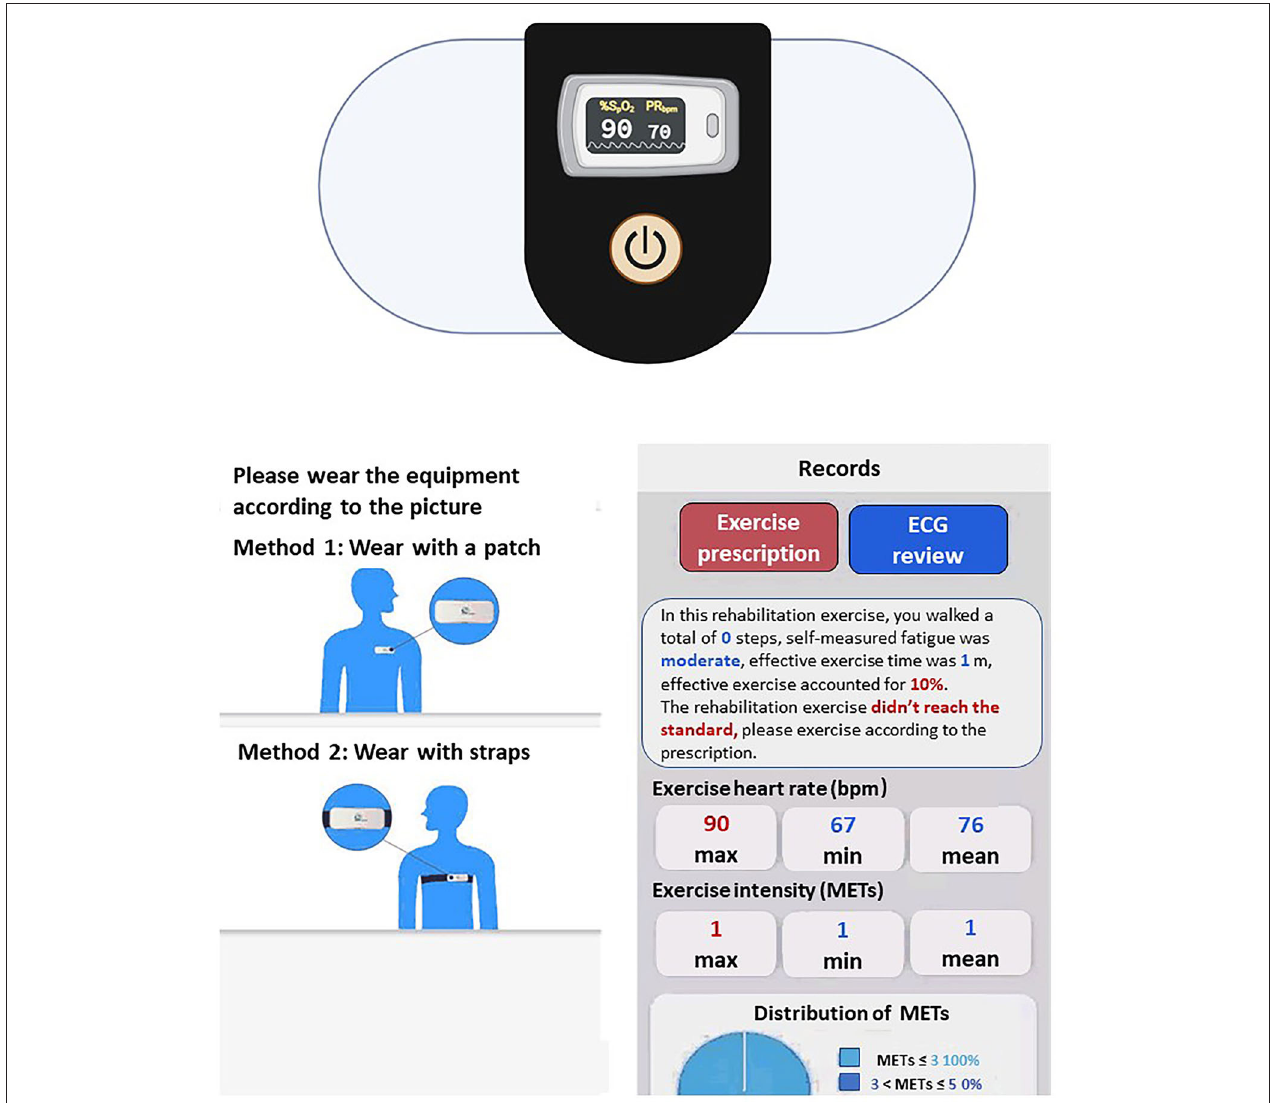
FIGURE 2 | The screenshot for the portable electrical equipment and the Xinankang app for patients (English version). Instructions on how to wear a close-fitting the portable electrical equipment and rehabilitation record details including metabolic equivalent, heart rate and exercise prescription,